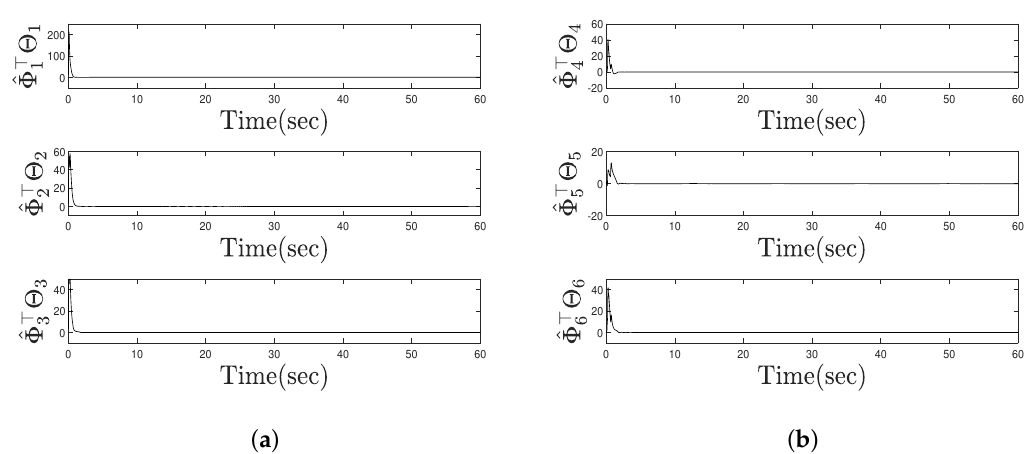
Figure 18. Outputs of radial basis function neural networks for Scenario 3 ( a ) Φ 1 Θ 1 , Φ 2 Θ 2 , and Φ 3 Θ 3 ( b ) Φ 4 Θ 4 , Φ 5 Θ 5 , and Φ 6 Θ 6 .